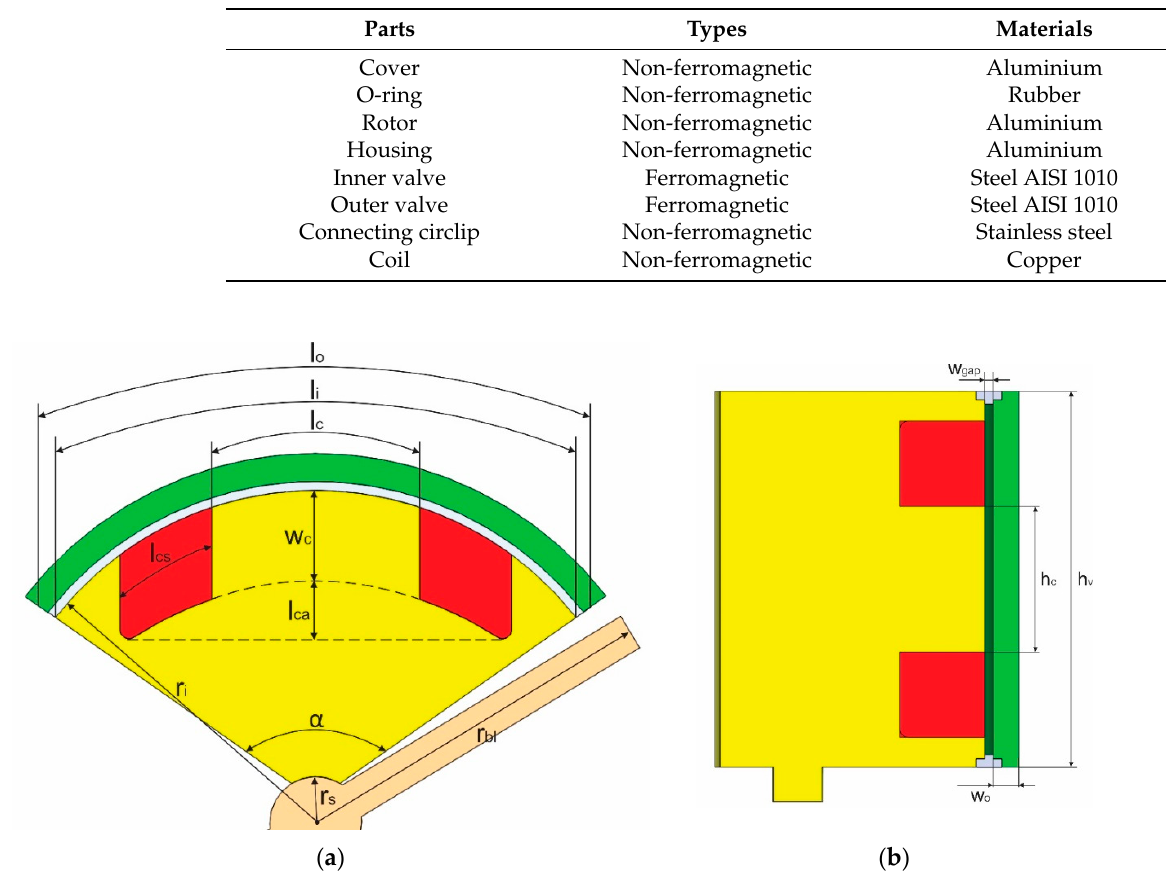
Figure 5. Dimensional specifications of the static valve: ( a ) Top view; ( b ) Side view. Table 2. TVMRB component materials.